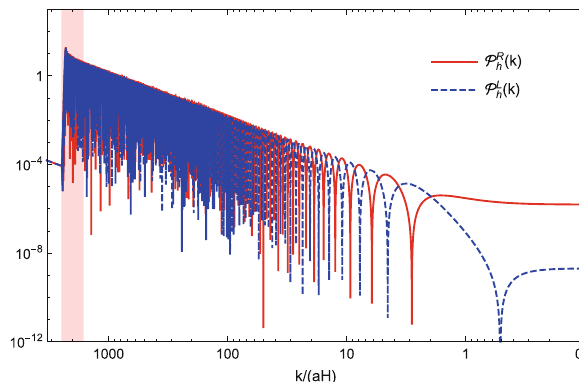
Fig. 3 The ratio of P R